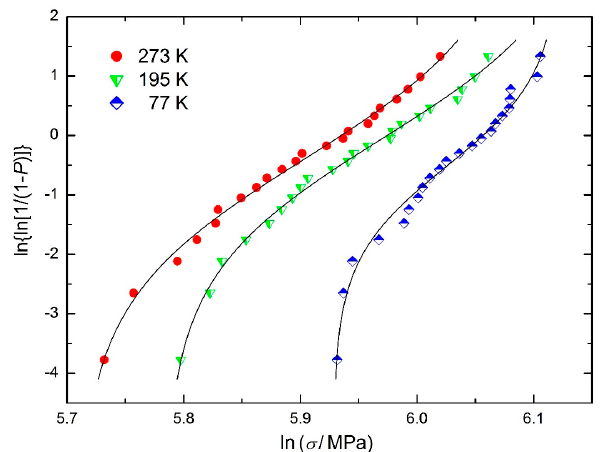
Figure 7. Weibull plots of the flexural strength of the aluminum nitride ceramic samples tested at given temperatures